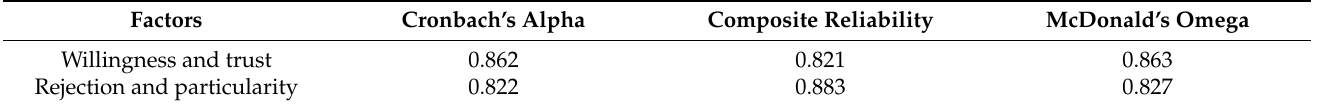
Table 5. The reliability of the measuring tools applied.